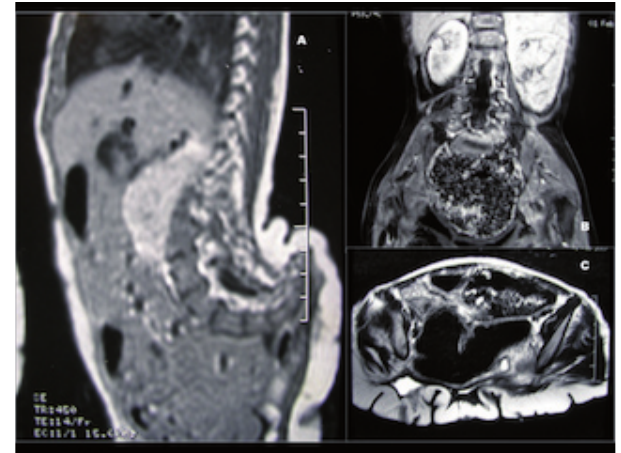
Figure 3. Nuclear magnetic resonance demonstrating exaggerated saccrococcygeal convexity ( A ); crossing ectopic right kidney and a intestinal malrotation ( B ); absence of pubic bone, and the corrugated skin covering the posterior perineal cavity ( C